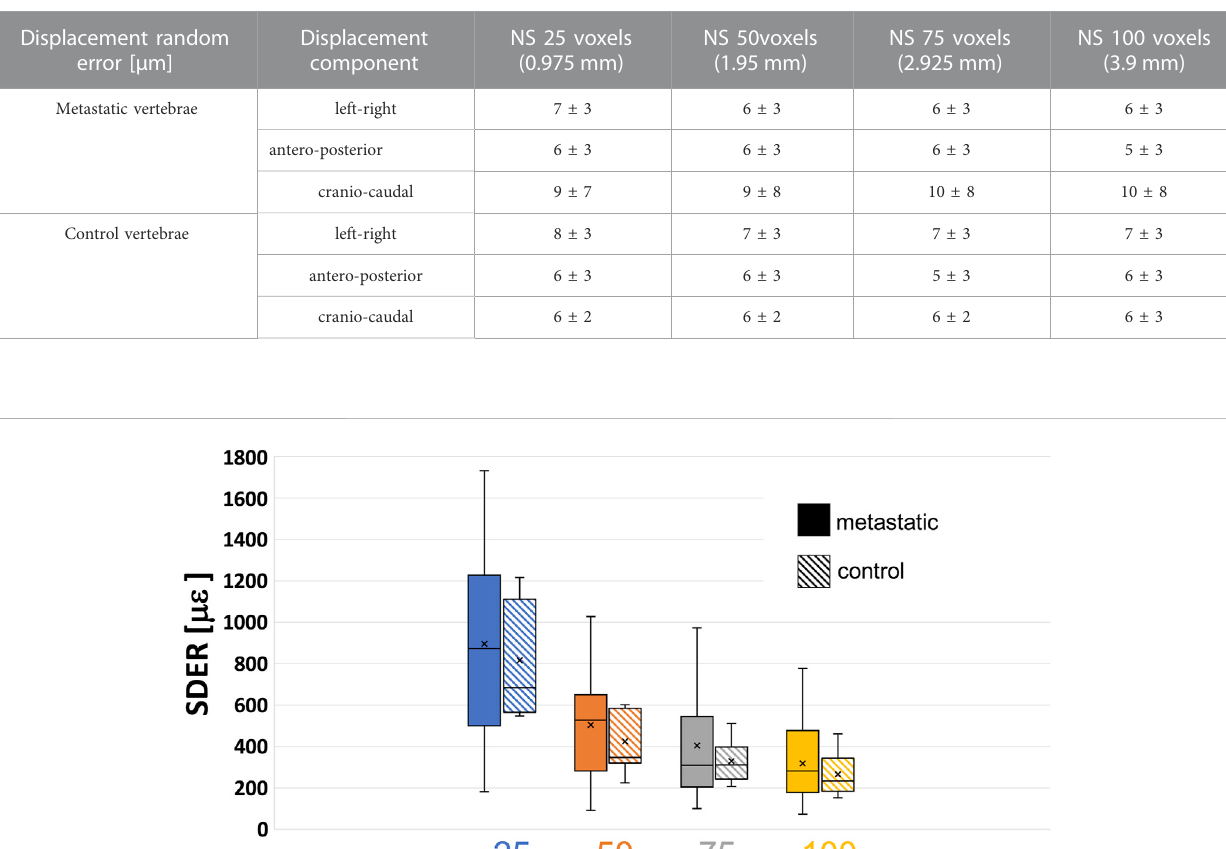
TABLE 3Displacement random errors [mean ± standard deviation] reported in μ m for the three Cartesian components of displacement for the different used NSs, for metastatic and control vertebrae.